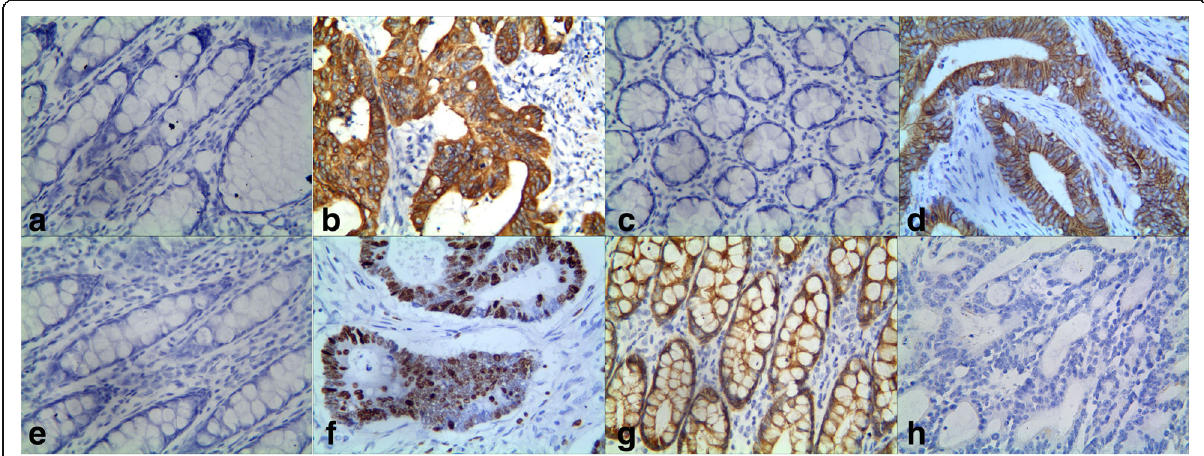
Fig. 1 Immunostaining for MACC1, CD44, Twist1, and KiSS-1 in colon adenocarcinoma and control tissue. a : Negative MACC1 in the control tissue (400 magnification); b : Positive MACC1 in the CAC tissue (400 magnification); c :Negative CD44 in the control tissues (400 magnification); d : Positive CD44 in the membrane and cytoplasm of cancer cells (400 magnification); e : Negative Twist1 in the control tissue (400 magnification); f : Positive Twist1 in the cytoplasm and nuclei of the cancer cells (100 magnification); g : Positive KiSS-1 in the cytoplasm of control cells (400 magnification); h : Negative KiSS-1 in the cancer tissue (400